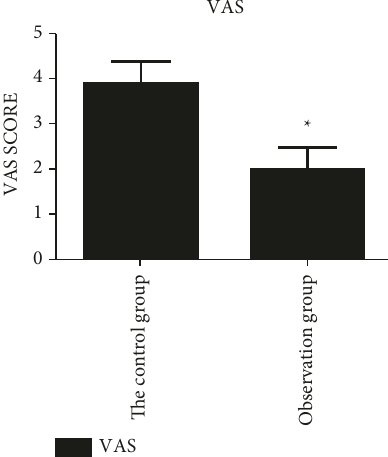
Figure 2: Comparison of VAS scores between the two